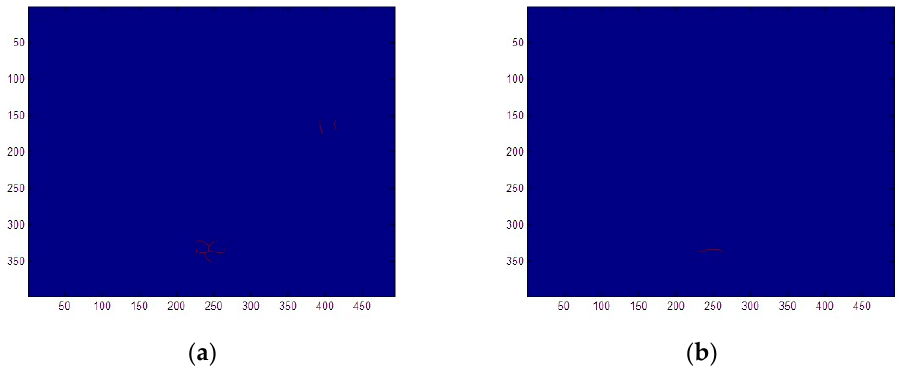
Figure 7. Abrasive hyper-heuristic skeleton extraction. ( a ) Direct skeleton extraction of wear debris. ( b ) Mathematical morphology hyper-heuristic skeleton extraction.